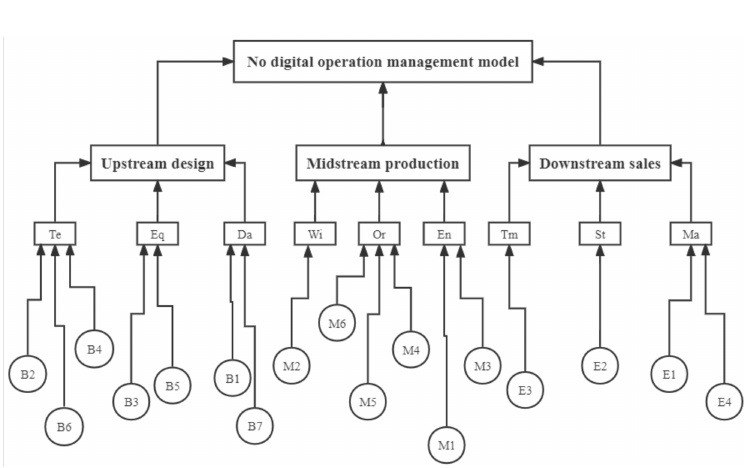
Figure 3. The Fault Tree Construction. Note: The figure is drawn based on Table